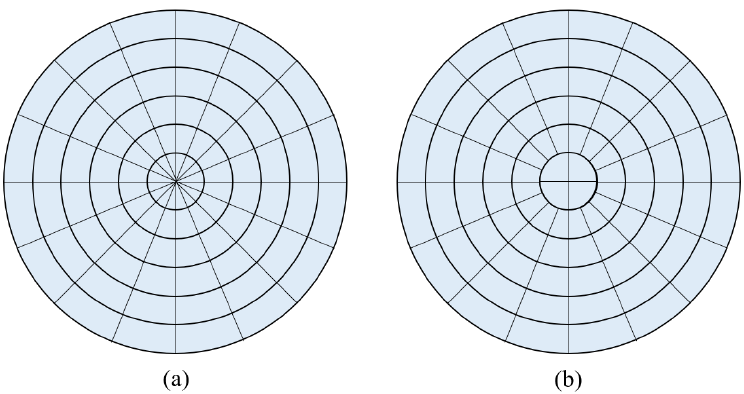
Figure 4. Bin-wise organization of laser point cloud: ( a ) Division method according to the equal- interval azimuth angles and radial distances; ( b ) Adjusted division method.